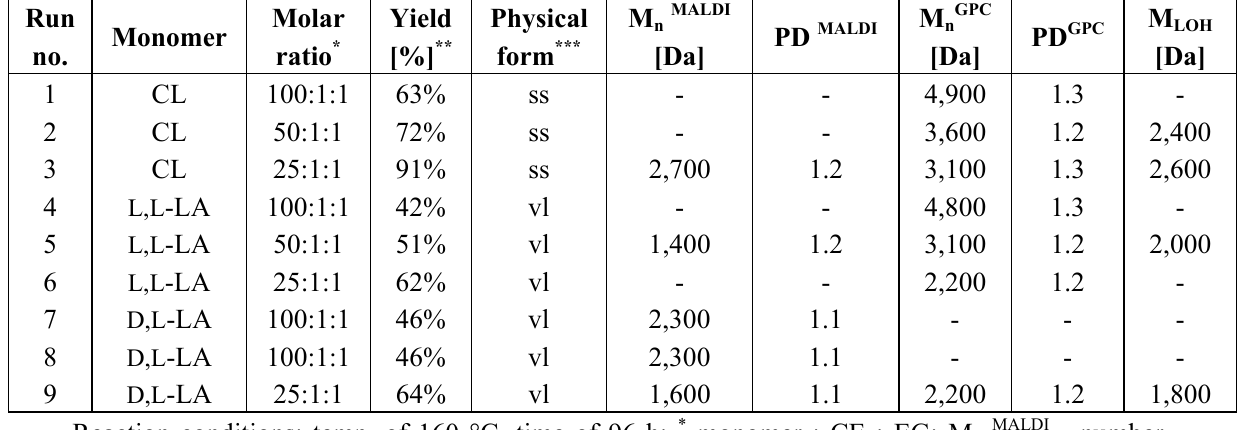
measurements; M - number-average molecular weight calculated from LOH